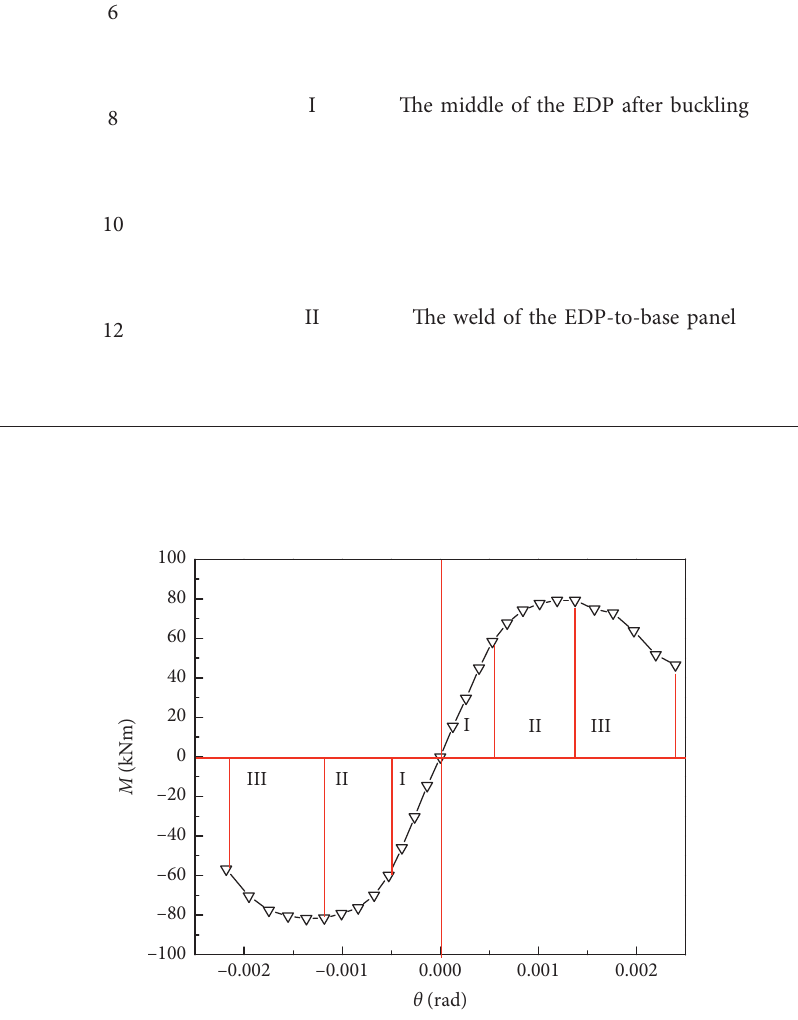
Figure 3: A typical skeleton curve of the energy-dissipation joint